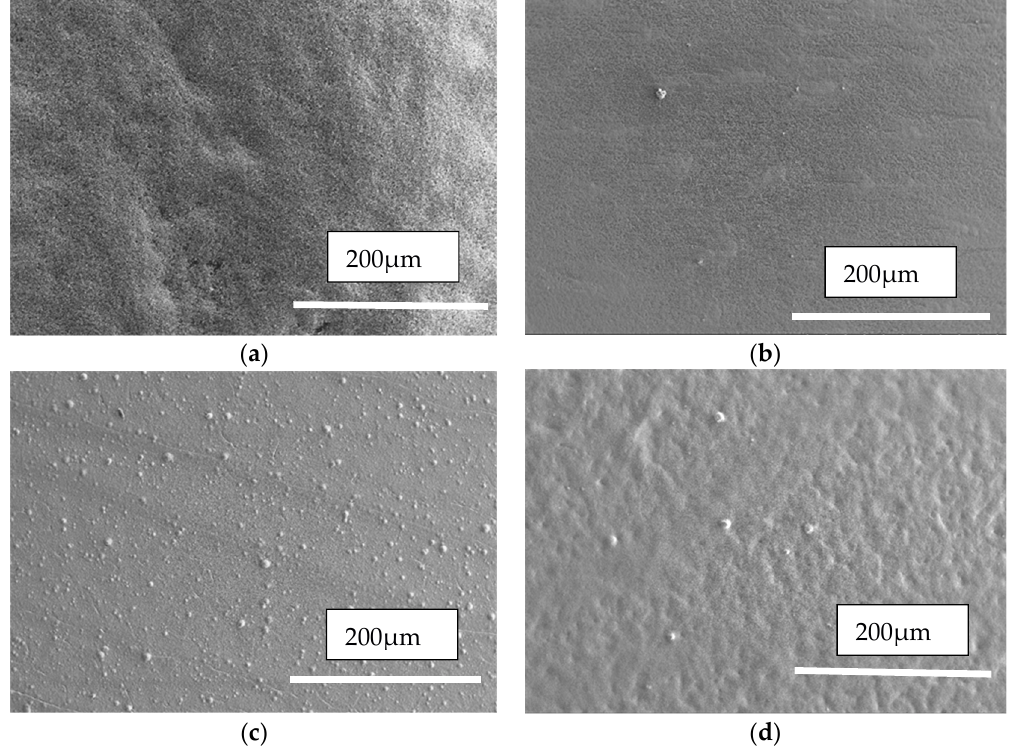
Figure 2. Dried suspensions of ( a ) C1, ( b ) C2, ( c ) HM1, and ( d ) HM2.